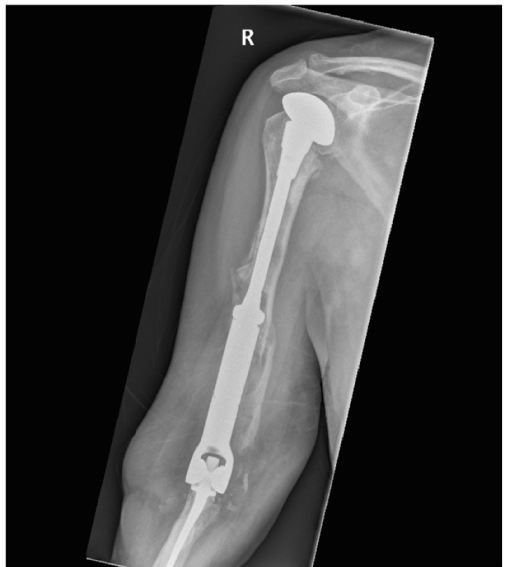
Figure 5. The radiograph shows IMHR for the second case, and it illustrates preservation of most of the proximal half of the humeral shaft with a shoulder hemi-arthroplasty proximally and a large humeral body distally joined to an elbow replacement ulnar component.